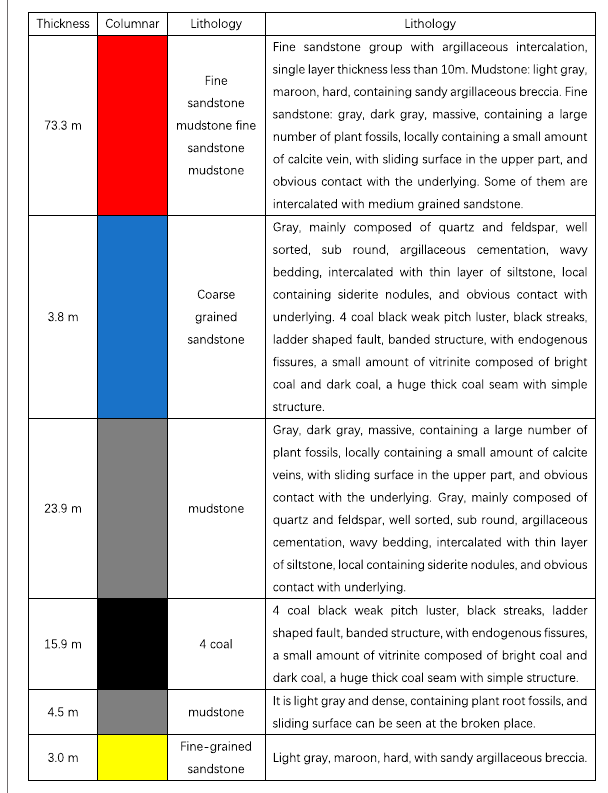
FIGURE 2 | Histogram for working face of a coal